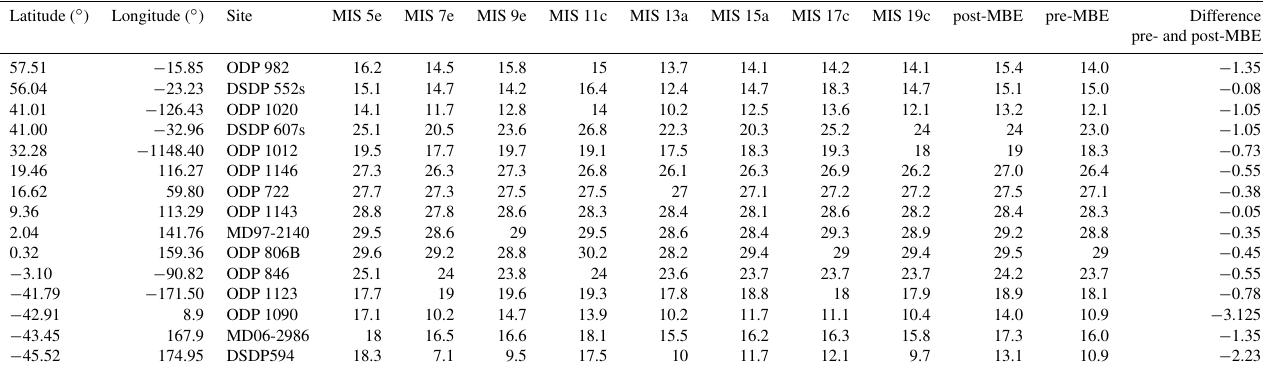
Figure 3. Annual SST ( ◦ C) in (a) the pre-industrial control simulation and (b–j) the interglacial simulations of the OC series with fixed vegetation and fixed ice sheets, in anomalies with respect to the pre-industrial control simulation. Table 3. SST data ( ◦ C) from the Past Interglacials Working Group of PAGES (2016) and shown in Figs. 4a and b and 14. Latitude ( ◦ ) Longitude ( ◦ )